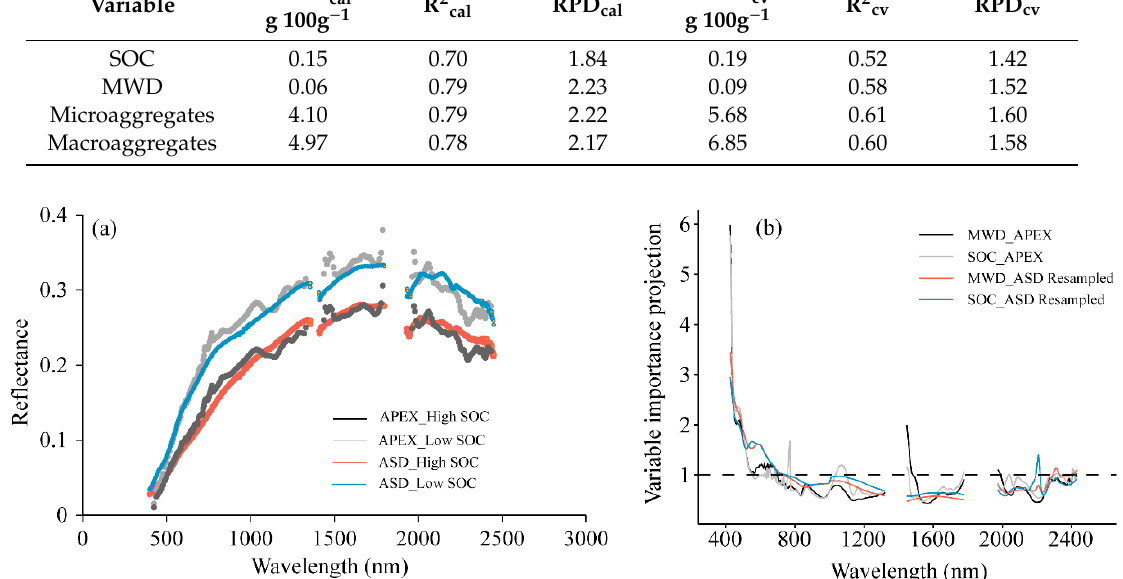
Table 2. Estimation accuracy of PLSR model calibration (cal) and cross-validation (cv) for SOC, MWD, microaggregates and macroaggregate fractions. Variable